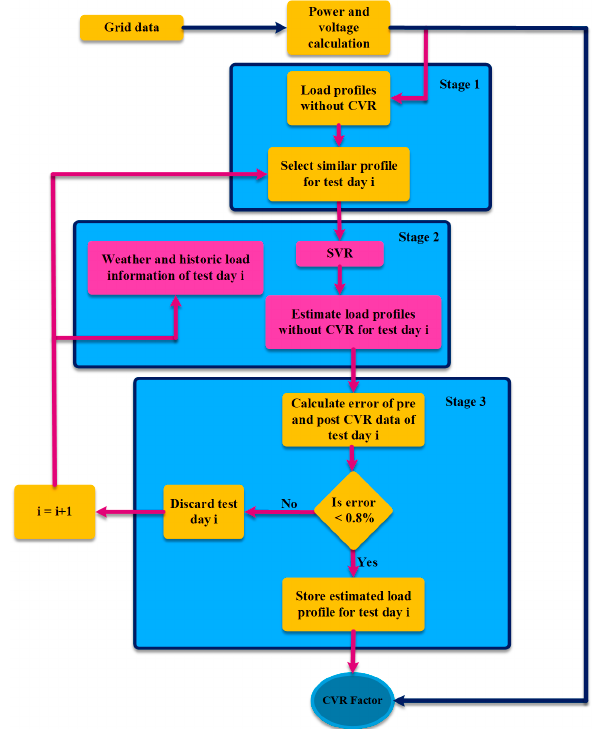
Figure 17. Structure of the SVM-based CVR quantification method [122].